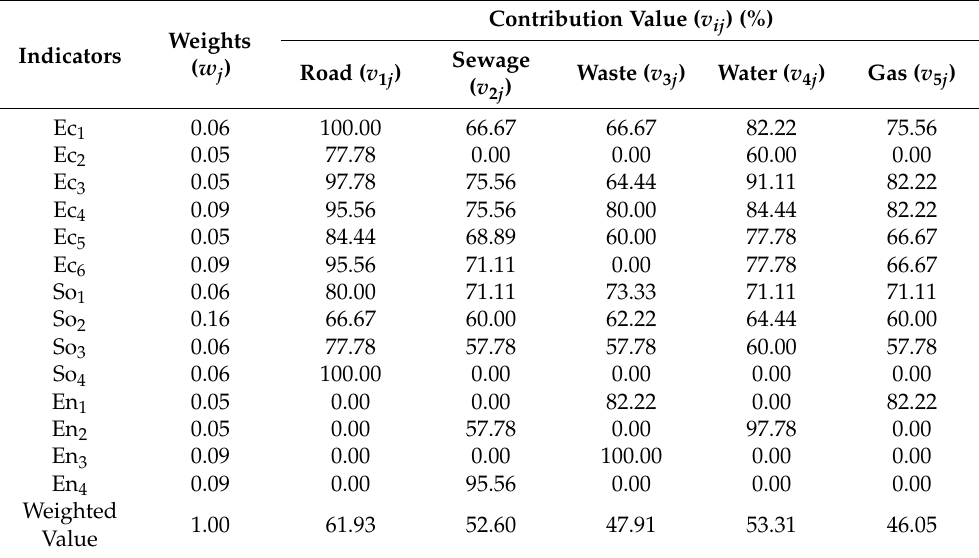
Table 9. Sustainable contribution of infrastructures to Jiansheng